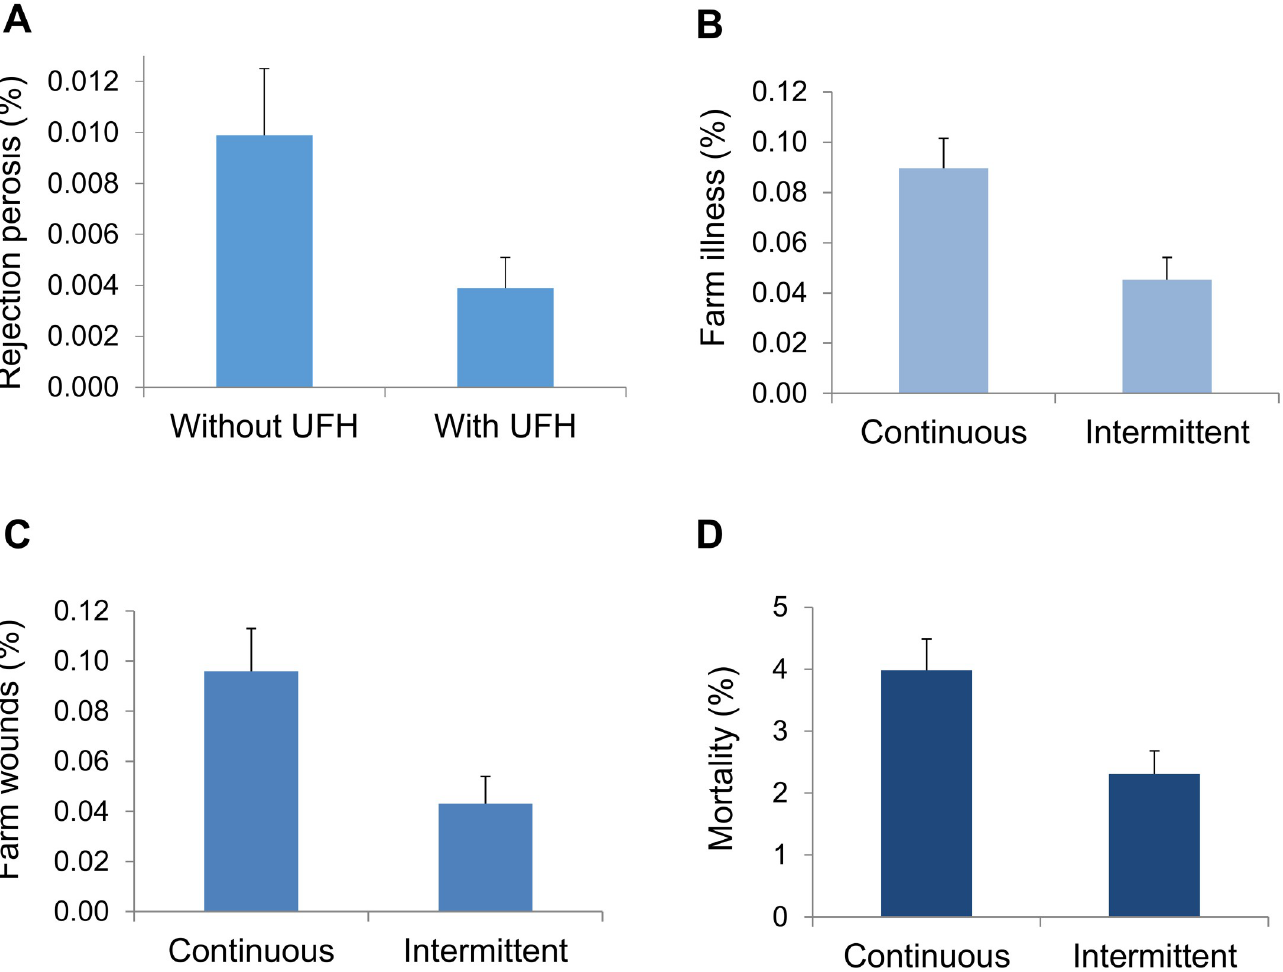
Fig 5. Associations of underfloor heating with (A) rejection due to perosis, and of photoperiod regimen on on-farm (B) illness, (C) skin wounds, and (D) mortality. Underfloor heating (UFH, without vs with). Photoperiod regimen (18 h continuous vs 16 h intermittent). Bars show back-transformed least squares means ± SE (differences, P < 0.05). (A) Carcasses rejected due to perosis (leg deformity) as a % of total number of slaughtered birds. (B, C) Birds detected with signs of illness, and skin wounds, as a % of the estimated number of birds in 4 assessed transects. (D) Number found dead and culled on the farm up to the day of slaughter as a % of number of chicks